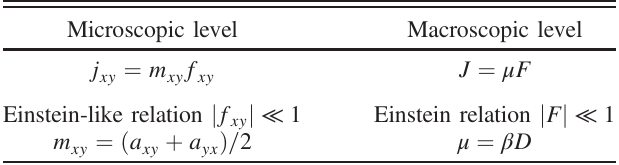
TABLE I. Analogy between the dynamical state mobility and macroscopic